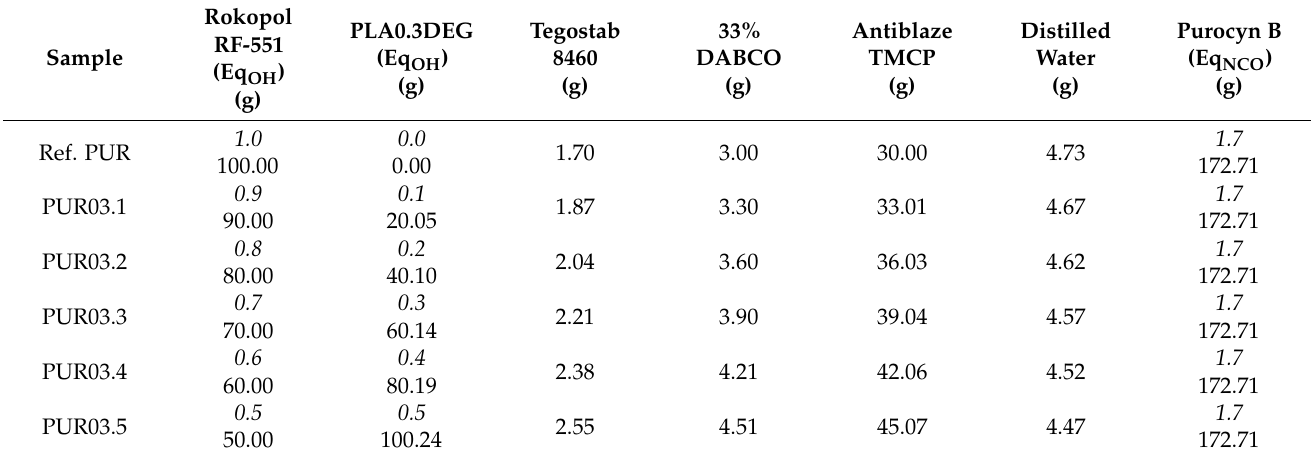
Table 10. Formulation of RPU foams with PLA0.3DEG eco-polyol.